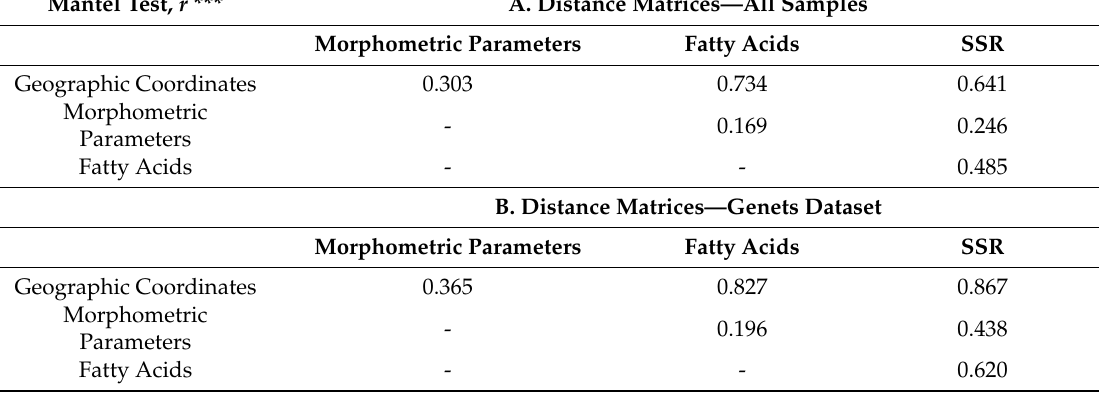
Table 3. Results of the Mantel test ( n = 169) carried out between pairs of four di ff erent distance matrices defined for macro-descriptors (for every comparison we report the correlation coe ffi cient r , simulated p -value < 0.001